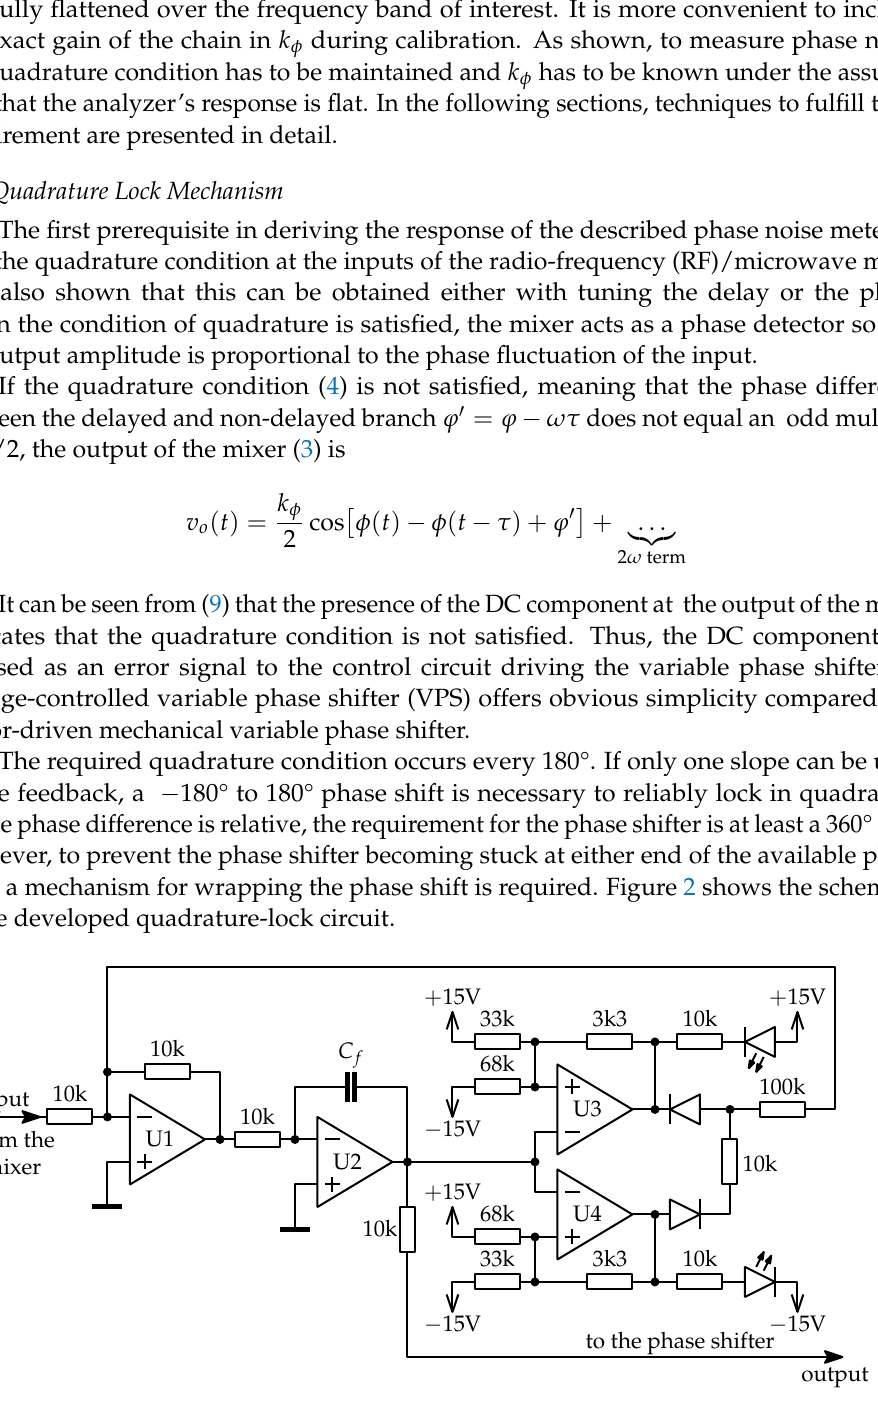
Figure 2. Schematic of the analog quadrature lock with phase wrap mechanism. Quadrature correction feedback is achieved by utilizing U2 as an integrator, which sets the tuning voltage for the voltage-controlled variable phase shifter. The value of C f in the feedback of the integrator was empirically selected to be 30 µF. No additional lead–lag network was required to improve the phase margin of the